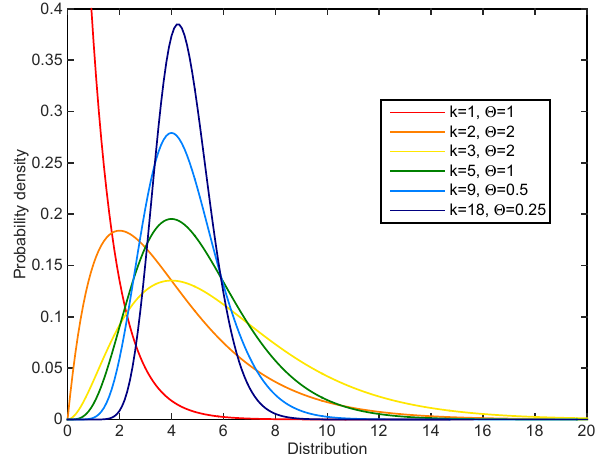
Figure 2. Gamma probability density functions (PDFs). All Gamma PDFs have a positive support, which is a crucial charac- teristic to realistically simulate sample steps. The gamma density probability functions were generated with the Matlab gampdf func-